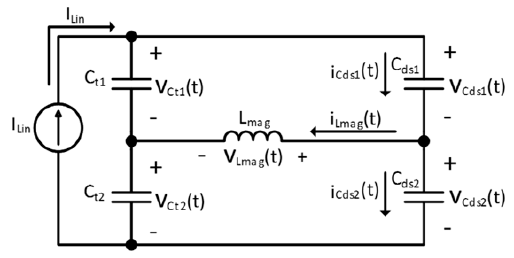
Figure 8. T gap equivalent circuit.